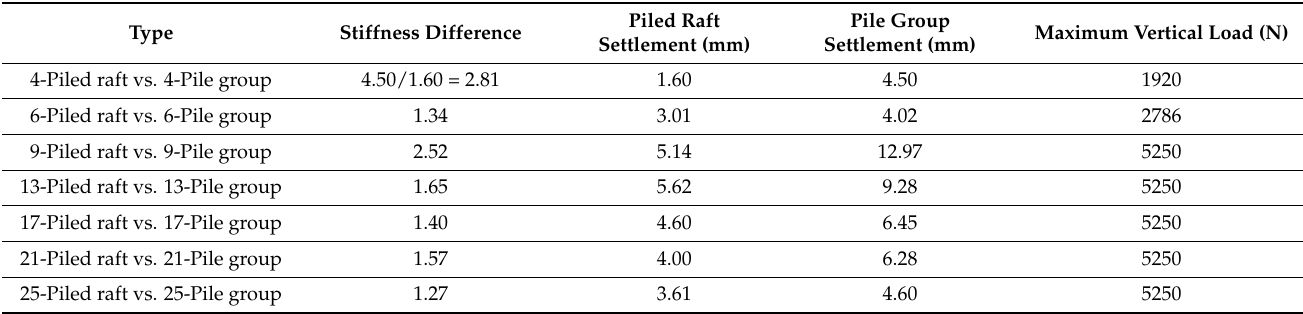
Table 1. Stiffness difference in pile Group vs. pile raft under vertical load.